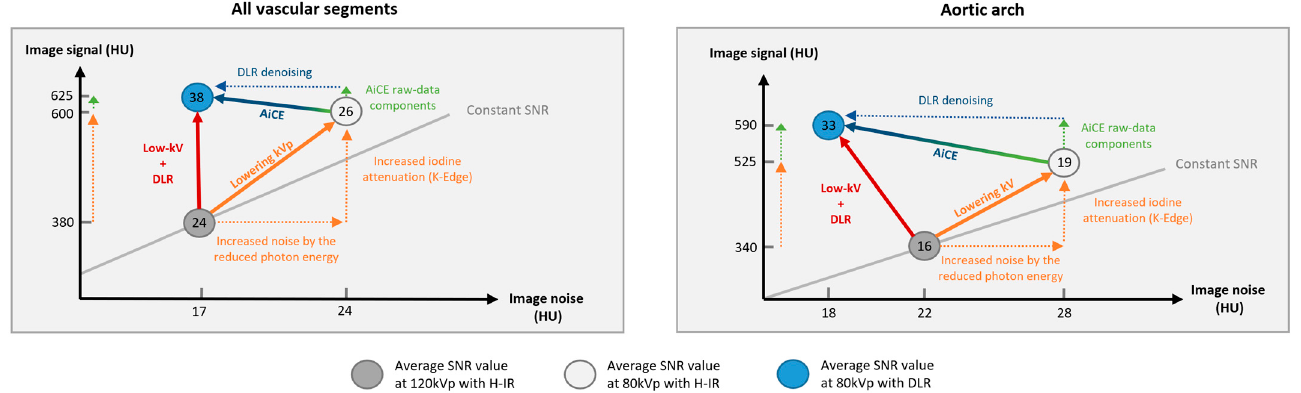
Figure 5. Schematic representation of the low-tube voltage approach combined with deep learning reconstruction to increase the signal-to-noise ratio vs. standard-kVp and iterative reconstruction protocol.